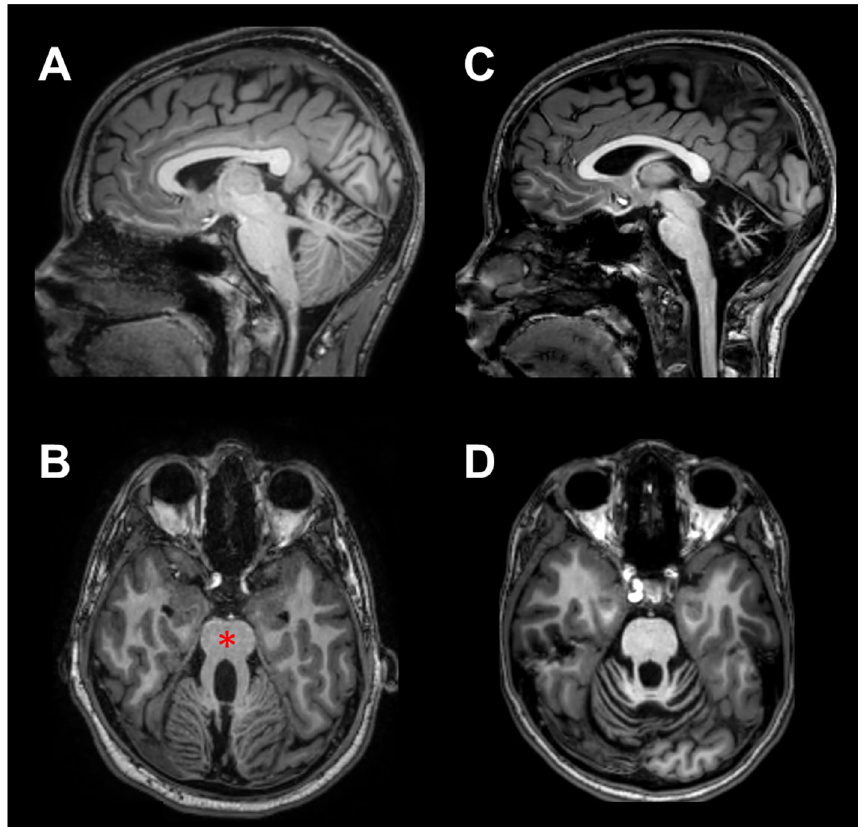
Figure 1. MRI scans of two representative ataxic children, in sagittal ( A , C ) and axial ( B , D ) views. In ( A , B ), scans of a child with non-progressive ataxia (NonP) show the typical vermian hypoplasia (“molar tooth” sign, red asterisk). In ( C , D ), scans of a child suffering from slow-progressive ataxia (SlowP) with evident generalized cerebellar atrophy are presented.